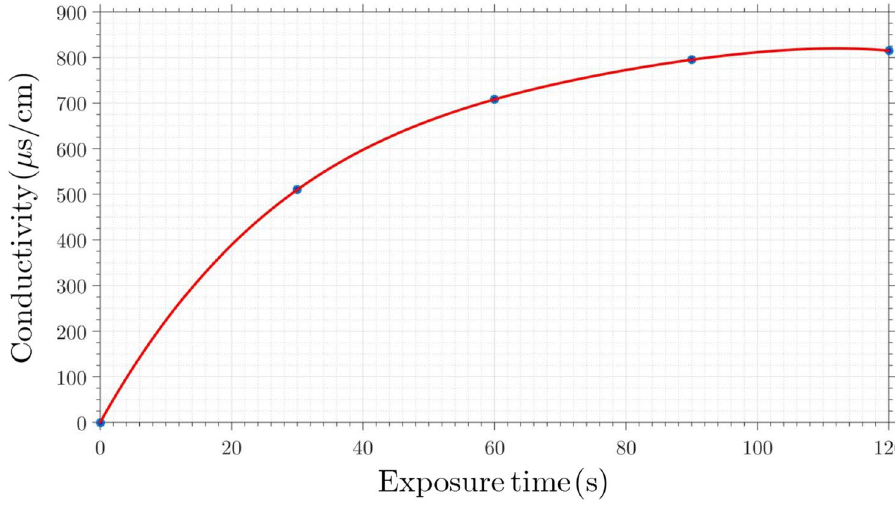
Figure 16. Conductivity of medium vs. the plasma exposure time.